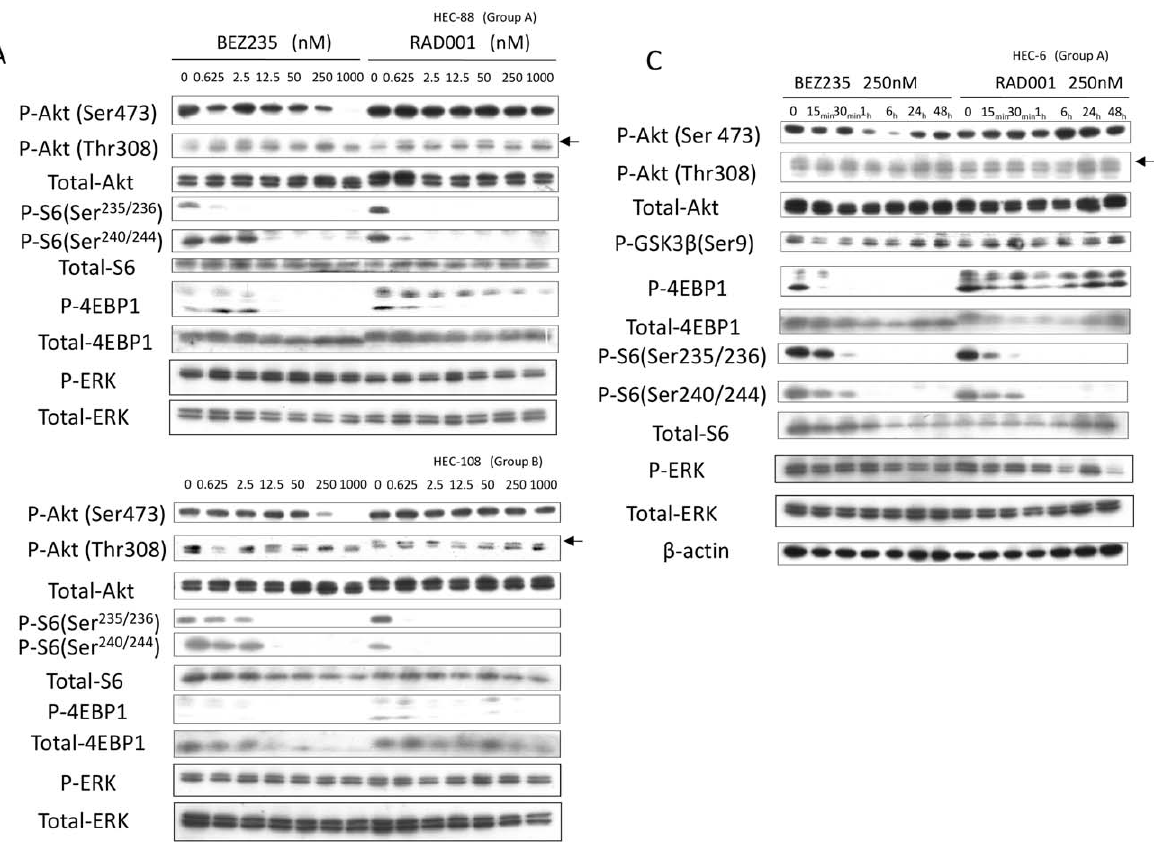
Figure 3. Inhibition of PI3K/mTOR signaling by NVP-BEZ235 and inhibition of mTOR signaling by RAD001 in endometrial cancer cell lines. (A)–(B) Western blot of total lysates of HEC-88 (group A) and HEC-108 (group B) cells, treated with NVP-BEZ235 or RAD001 at concentrations ranging from 0 to 1,000 nmol/L with 10% fetal bovine serum (FBS). phospho-Akt (Ser473, Thr308), phospho-S6 (Ser235/236, Ser240/ 244), and phospho-4EBP1 (Thr 37/46) levels are shown with total Akt level for a loading control. (C) Western blot of total lysates of HEC-6 (group A) cells treated with NVP-BEZ235 or RAD001 at a dose of 100 nM for up to 48 hours with 10% FBS. Phosphorylation levels of the PI3K/mTOR signaling are shown with loading